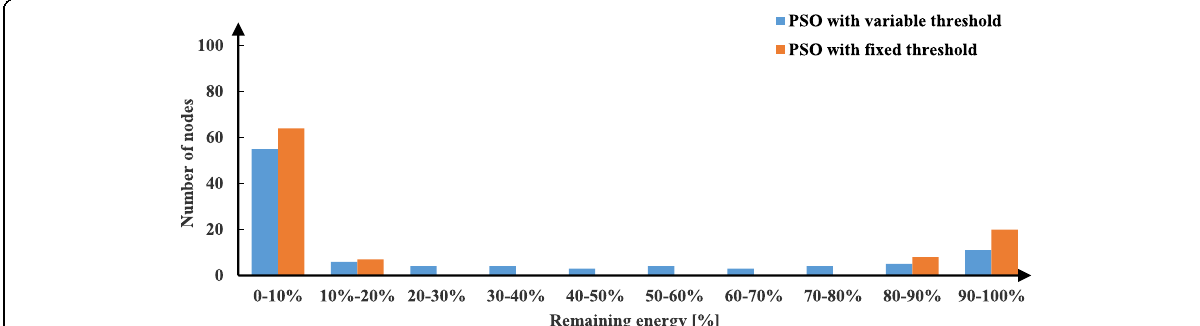
Fig. 18 Comparison of histogram of remaining energy distribution. This figure shows the histogram of the energy consumption of the